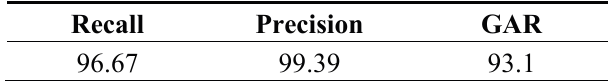
Table 8. The accuracies of face detection and recognition with the images of extremely rotated face (unit: